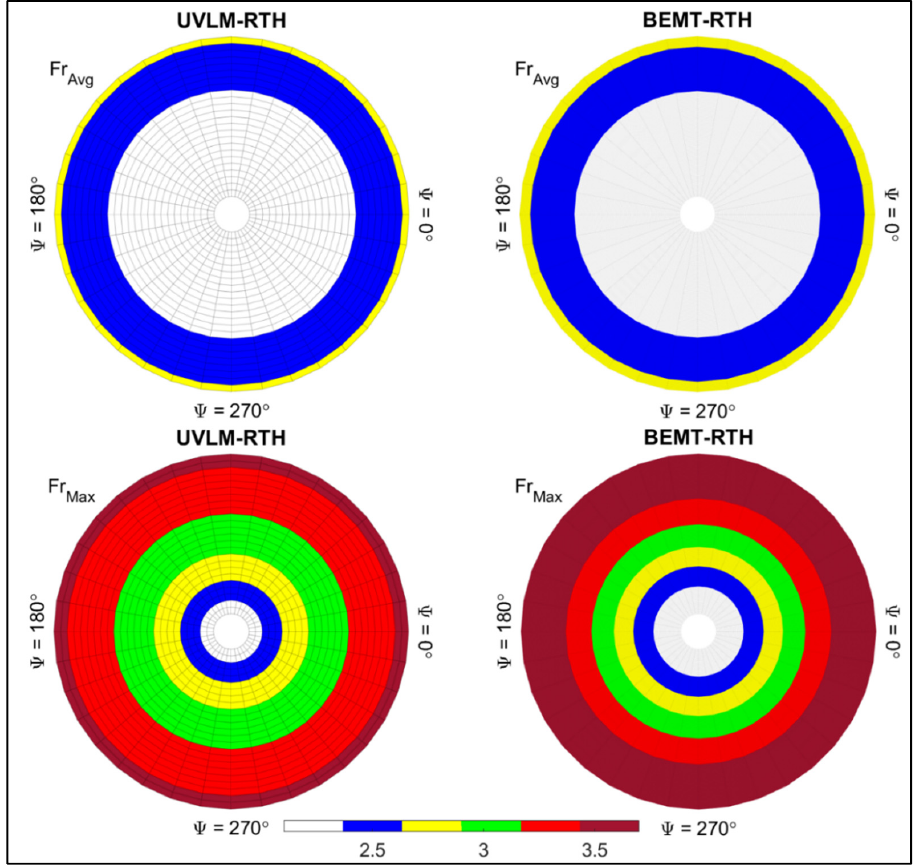
Figure 19. Contours of steady state Fr Avg and Fr Max for the modified Bell 429 tail rotor in axial flight obtained using BEMT-RHT and UVLM-RHT.